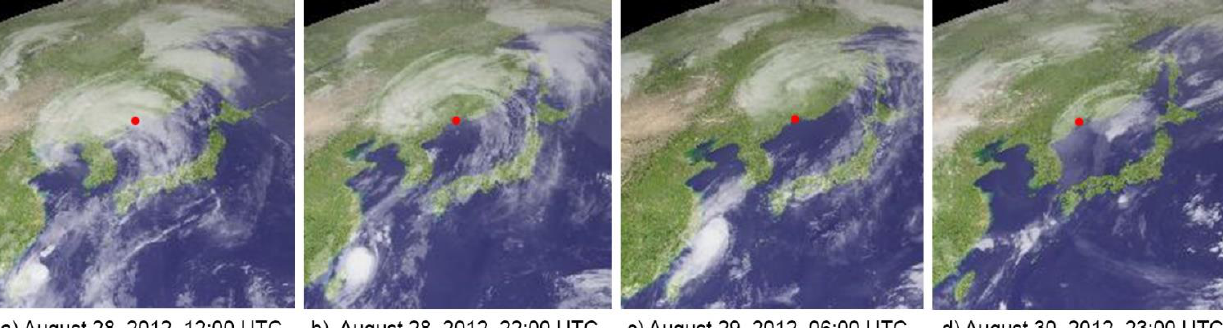
Figure 7. MTSAT-2 images of the Bolaven tropical cyclone.